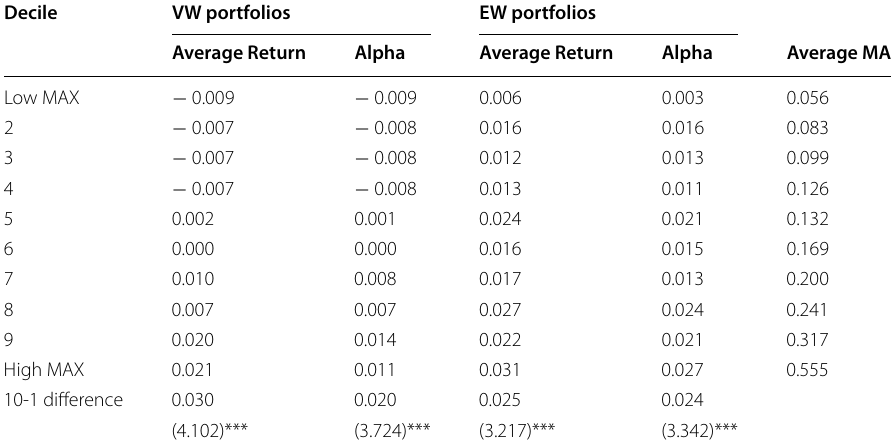
Decile portfolios are formed every week from January 2014 to September 2020 by ranking cryptocurrencies based on the maximum daily return (MAX) within the past month. Decile 1 (10) is the portfolio of cryptocurrencies with the lowest (highest) maximum daily return over the previous month. Table presents the value‑weighted (VW) and equal‑weighted (EW) average weekly returns, three‑factor alphas on the value‑weighted and equal weighted portfolios, and average maximum daily returns of cryptocurrencies within the past month. The bottom two rows report the differences in weekly returns and the differences in alphas between portfolios 10 and 1, and the corresponding t‑statistics. Newey‑West (1987) adjusted t‑statistics are presented in parentheses ***, ** and * denote significance at 1%, 5% and 10%,